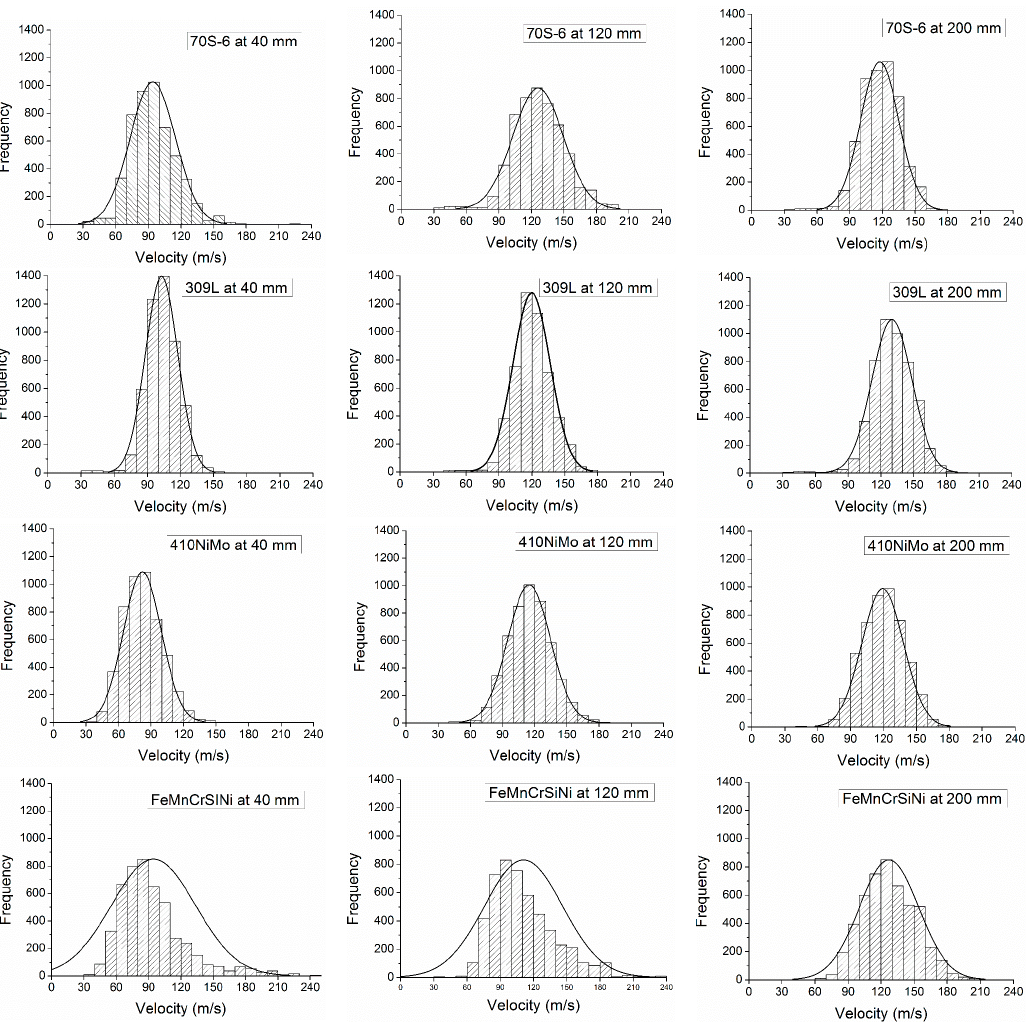
Figure 6. Histograms of the particles’ velocity collected in different distance from the gun.